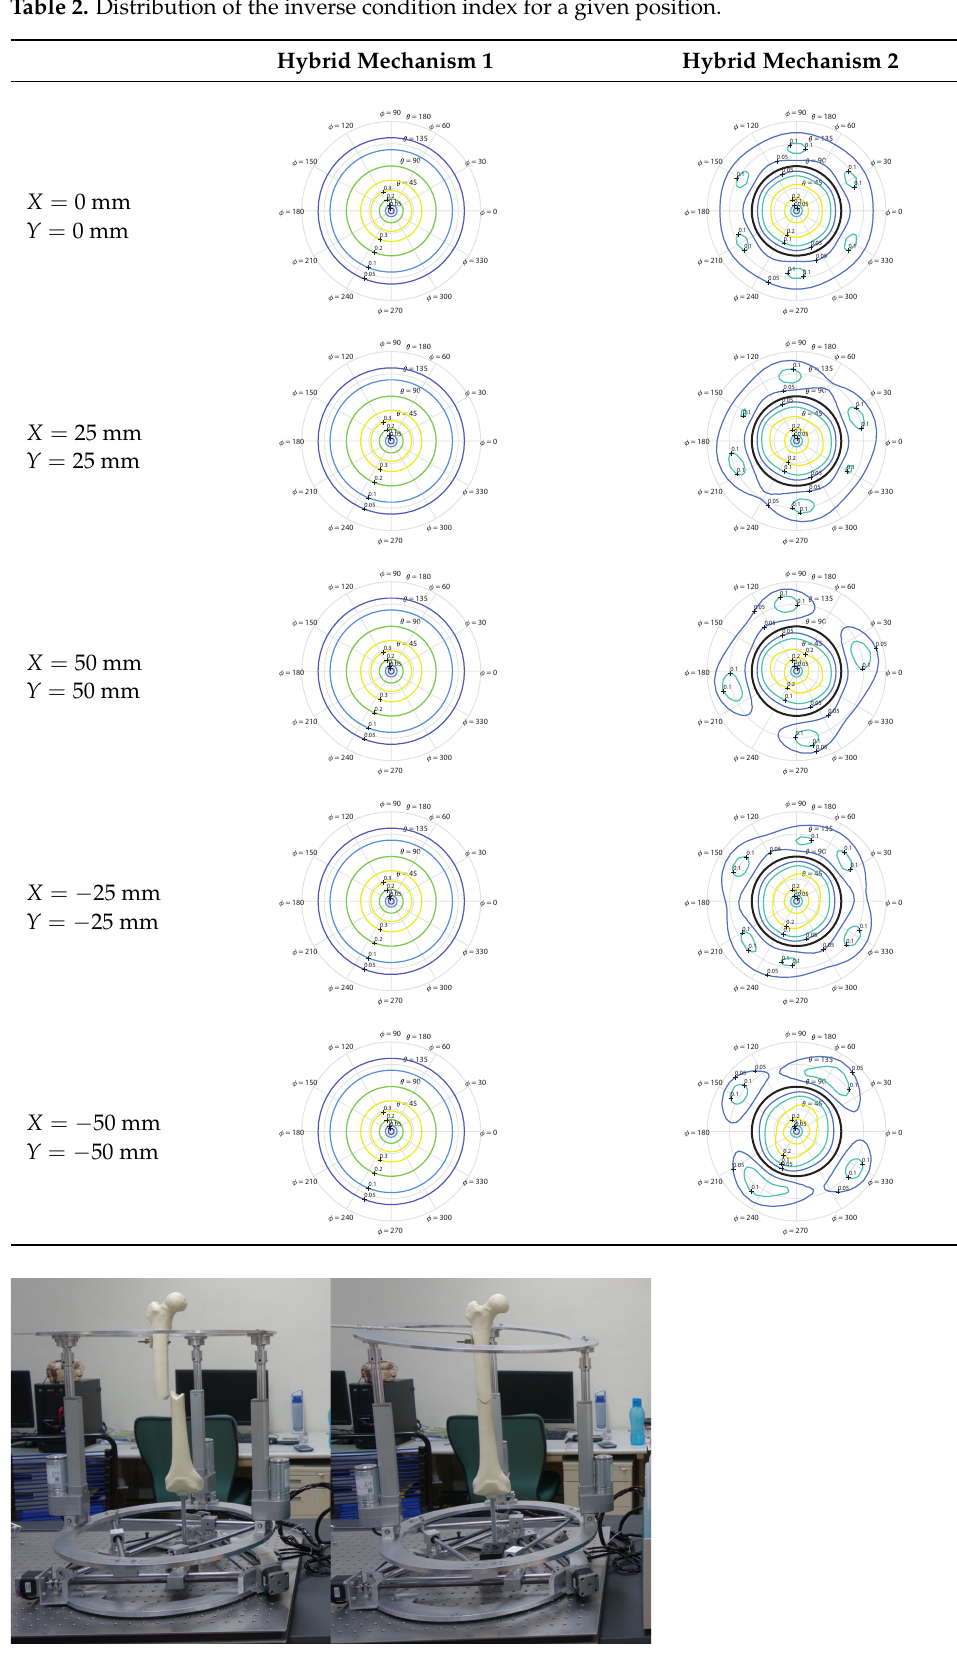
Figure 12. Experiment on the robotic Hybrid Mechanism 1, before and after bone